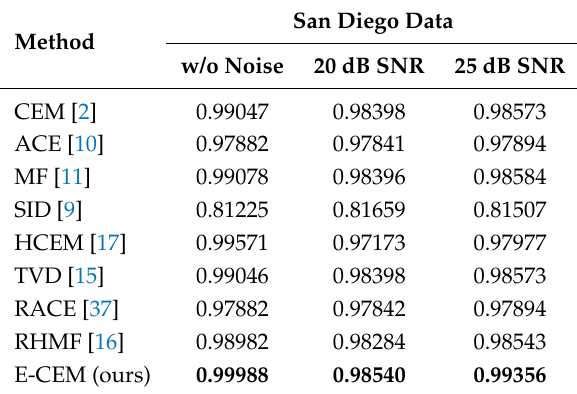
Table 2. The area under the ROC curve of different algorithms on AVIRIS San Diego data under the interference of white Gaussian noise with different SNR.